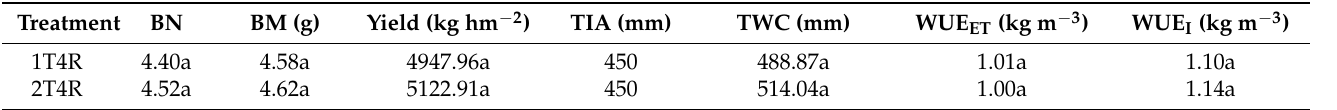
Table 4. Effects of different drip irrigation belt layouts on yield and irrigation water use efficiency of cotton in